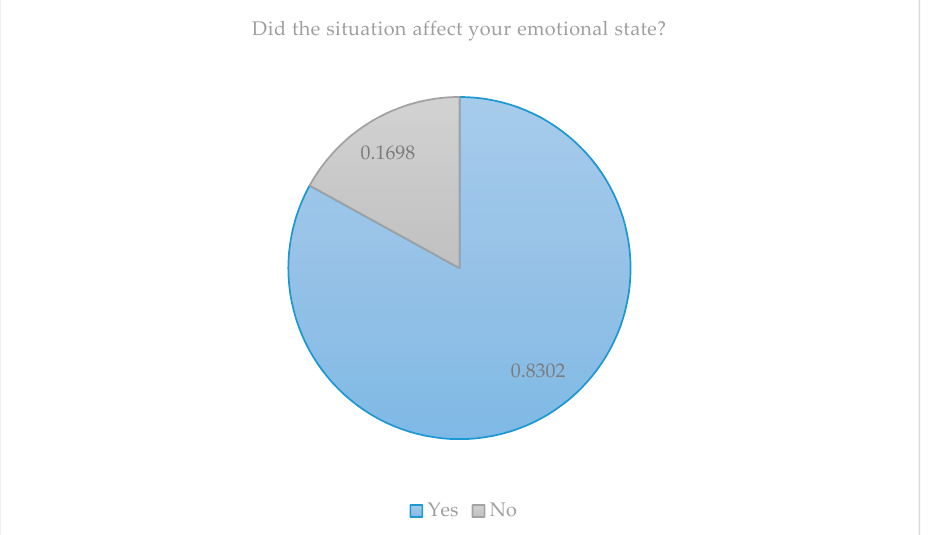
Figure 2. Impact of the situation on the parents’ emotional state.